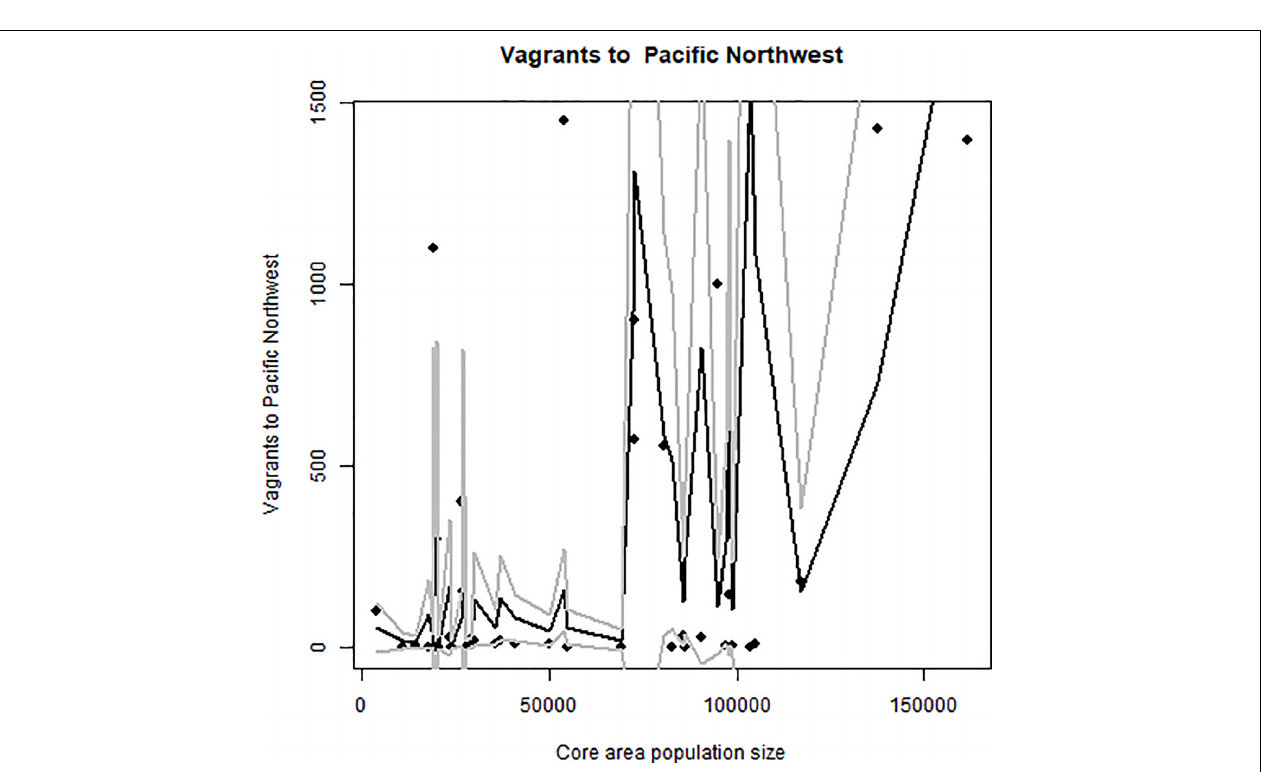
FIGURE 6 | Occurrence of vagrant elegant terns in Washington and Oregon, relative to abundance at Pacific breeding colonies. Predicted values and confidence intervals shown.